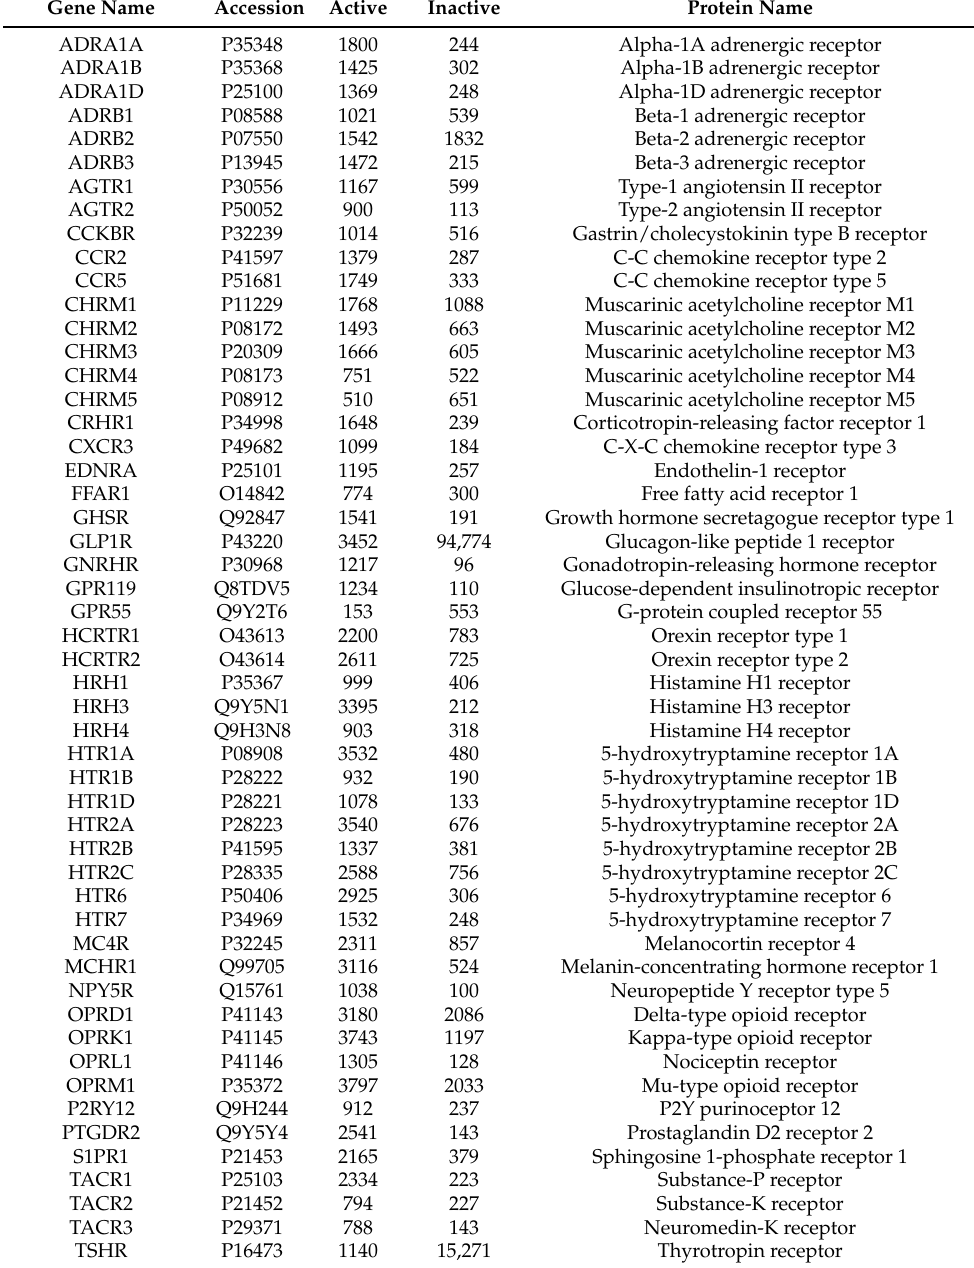
Table 1. List of 52 GPCRs that were selected as virtual orphan targets in this study. In the table, the active column shows the number of ligands that are active ( ≤ 1 µ M), and the inactive column shows the number of ligands that are inactive ( ≥ 3 µ